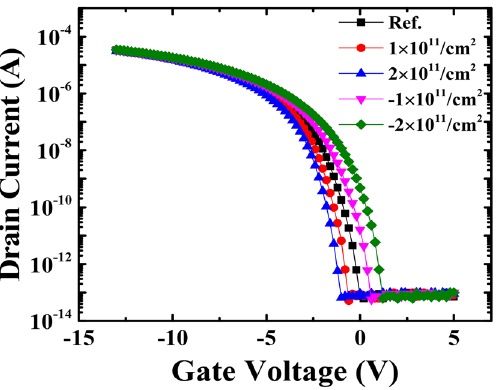
Figure 8. I D –V G plot based on the amount of charge trapped at the SiO 2 and PI interface by TCAD simulation.